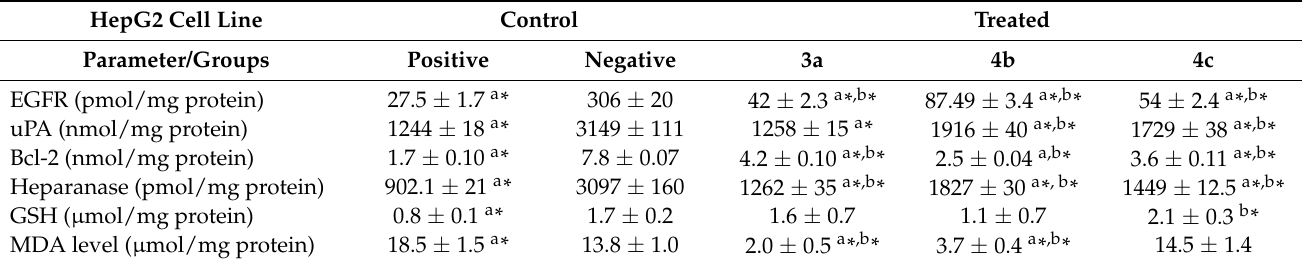
Table 4. Effects of treatment with the superior isatin sulfonamide derivatives ( 3a , 4b , and 4c com- pounds) on the levels of EGFR, uPA, BcL-2, heparanase, GSH, and MDA in cell lysate from HepG2 cells treated with the selected compounds at their